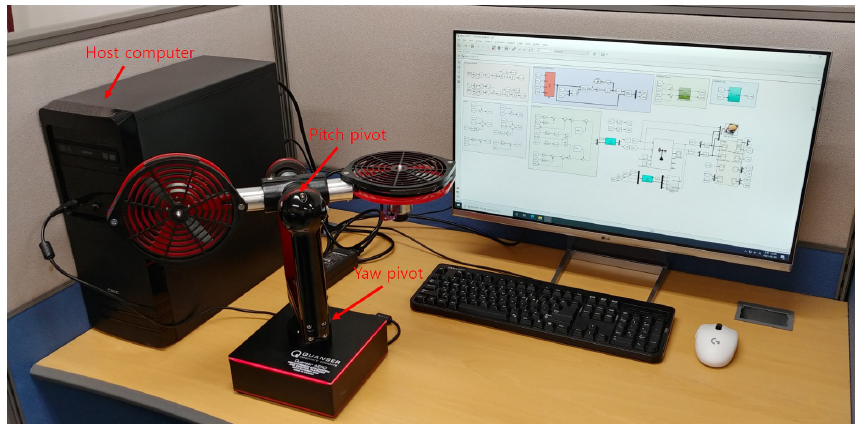
Figure 6. Experiment setup.